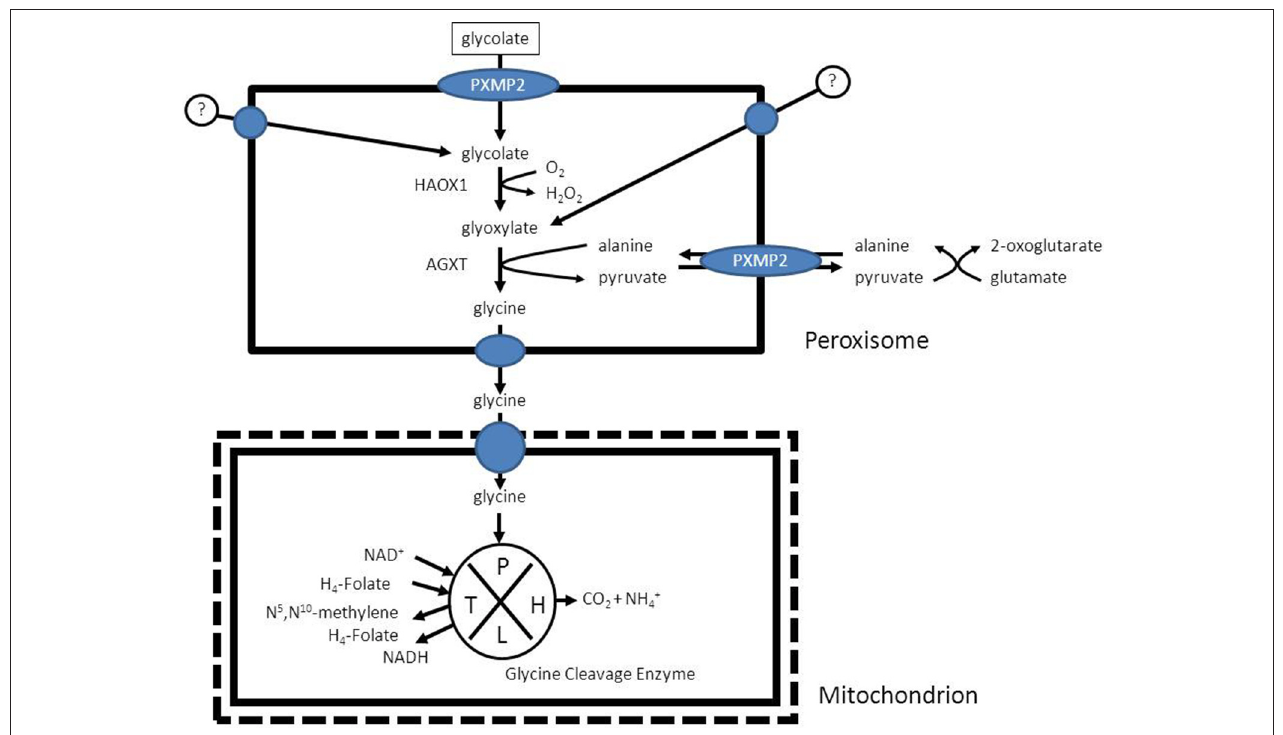
FIGURE 10 | The detoxification of glyoxylate in peroxisomes as catalyzed by the enzyme alanine glyoxylate aminotransferase